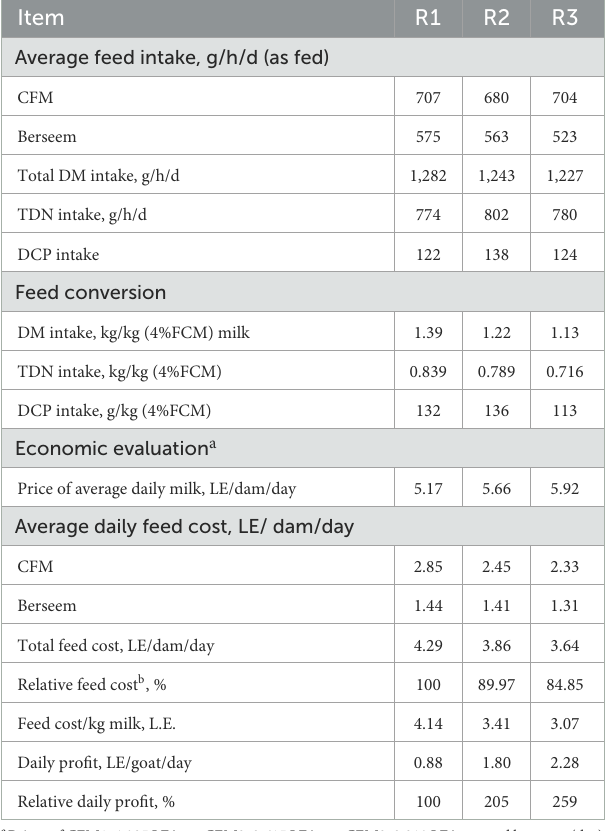
TABLE 8 Effects of inclusion of azolla on daily feed intake, feed conversion, and economic